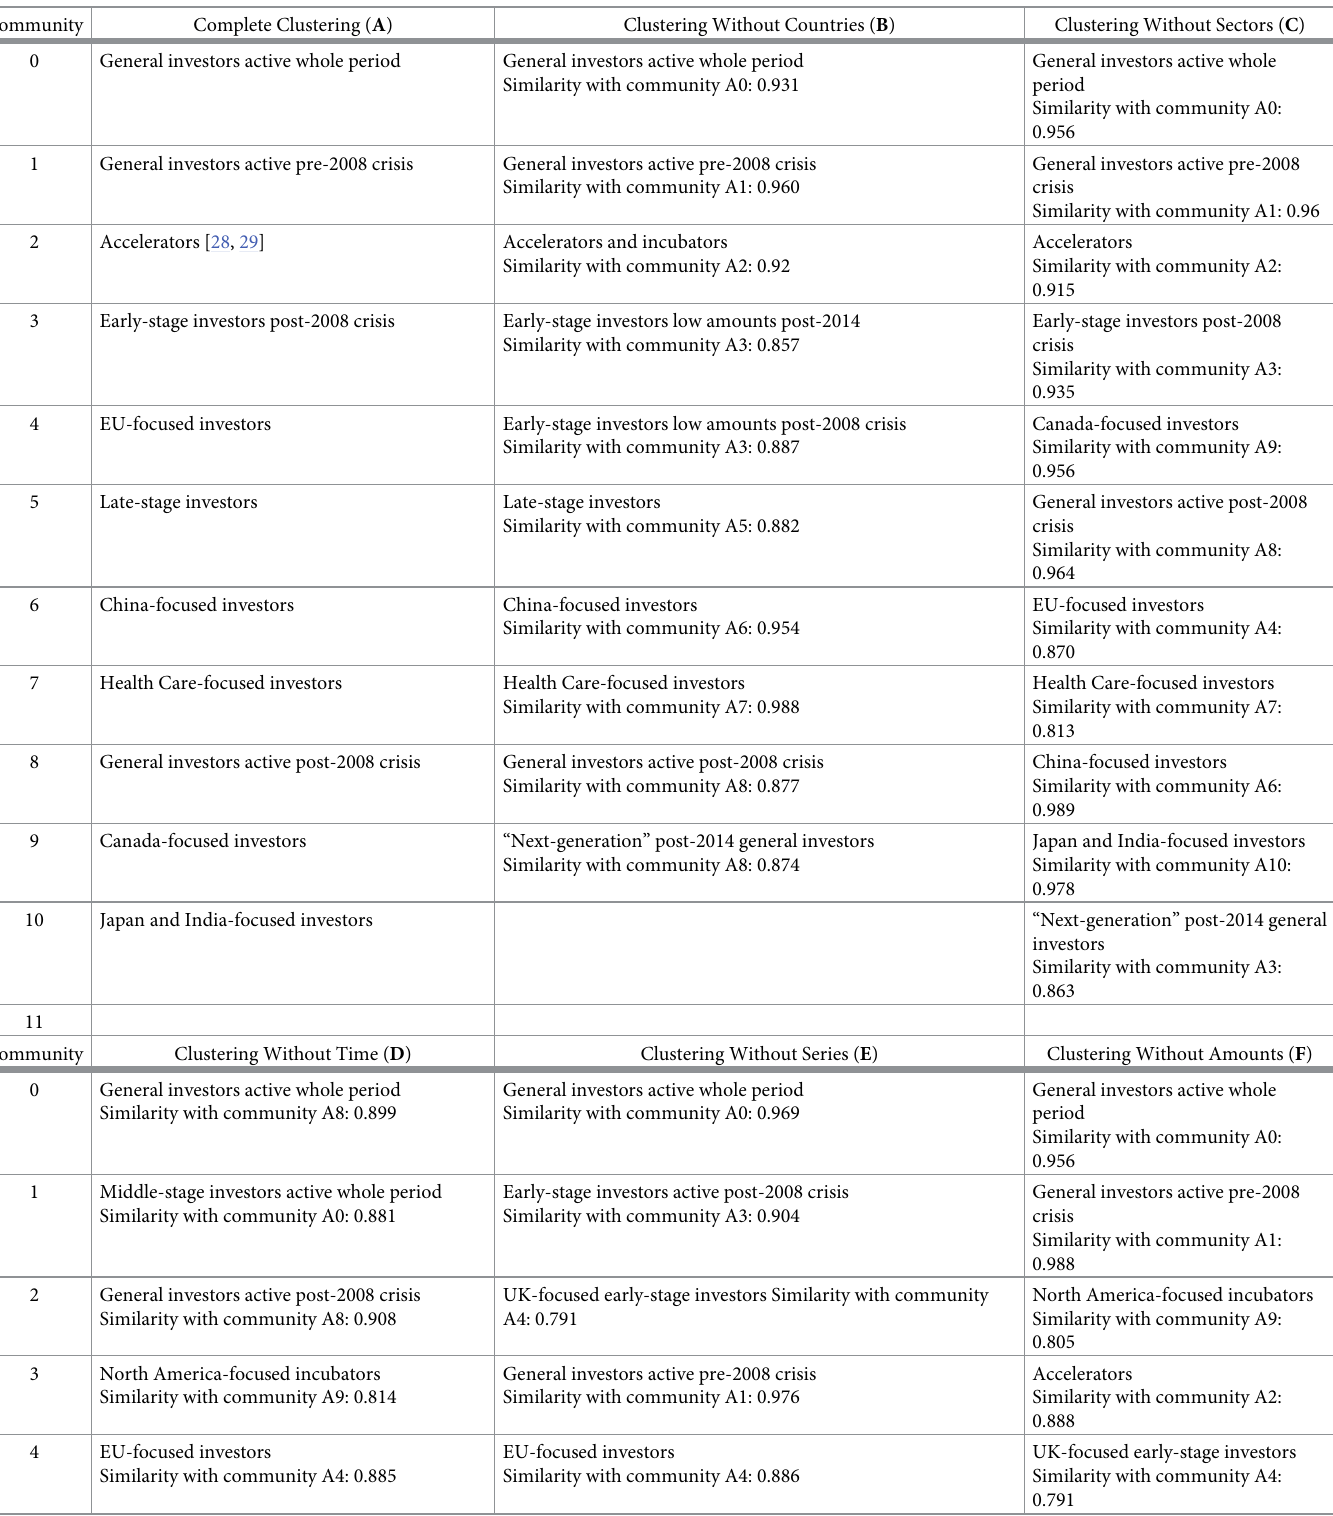
Table 1. Descriptive table of the communities for the different